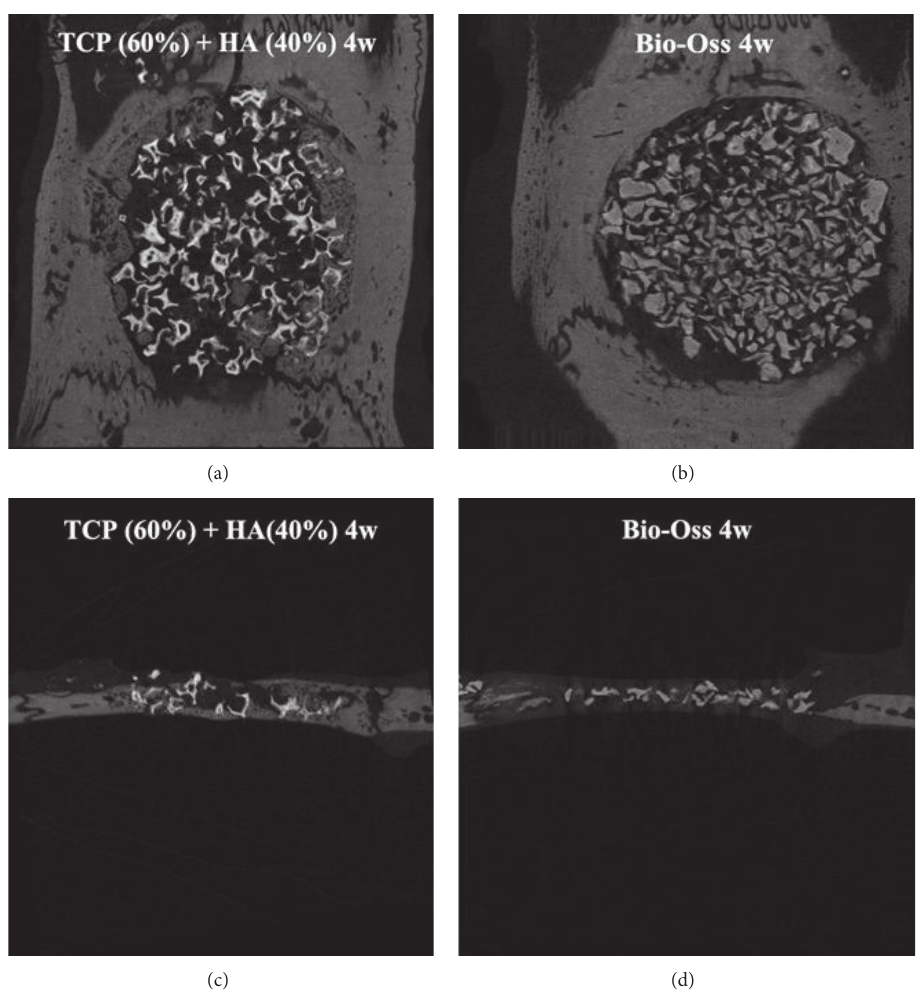
Figure 5: Micro-CT results of 60TCP40HA and Bio-Oss 4 weeks after